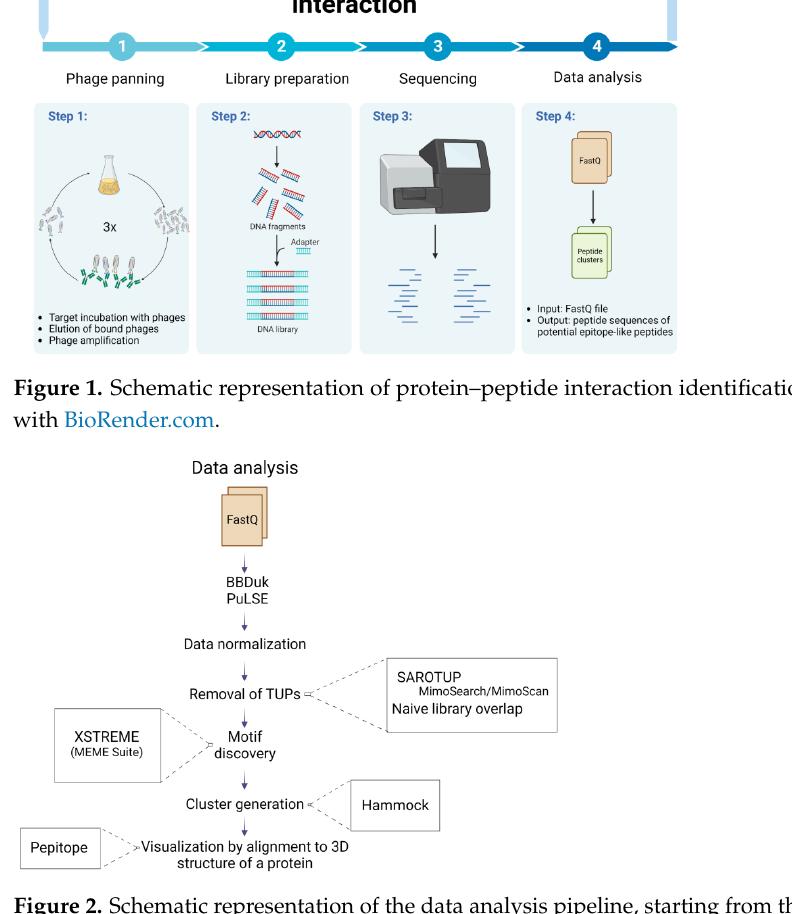
Figure 2. Schematic representation of the data analysis pipeline, starting from the FastQ file input, to the alignment of selected peptides to the 3D structure of the allergen. Created with BioRender.com.